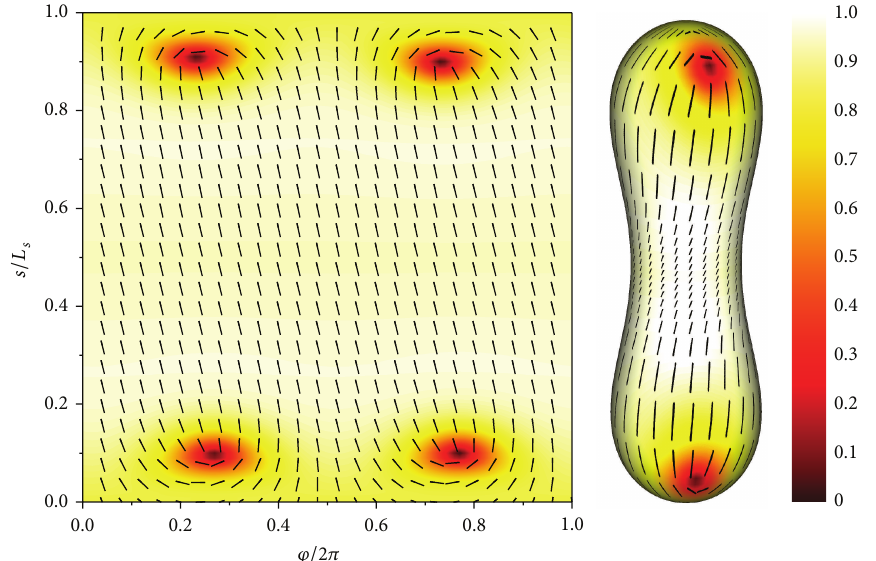
Figure 5: Vector field of molecules and contour plot of 𝜆/𝜆 𝑐 ratio, where the condensation value 𝜆 𝑐 stands for the highest possible value of 𝜆 at given 𝑡 < 0 reduced temperature. The calculations were performed for 𝑅/𝜉 reduced volume V = 0.70 , calculated in the spontaneous curvature model for 𝐶 0 = 0 . A schematic representation of the vector field and the contour plot on a vesicle is on the right